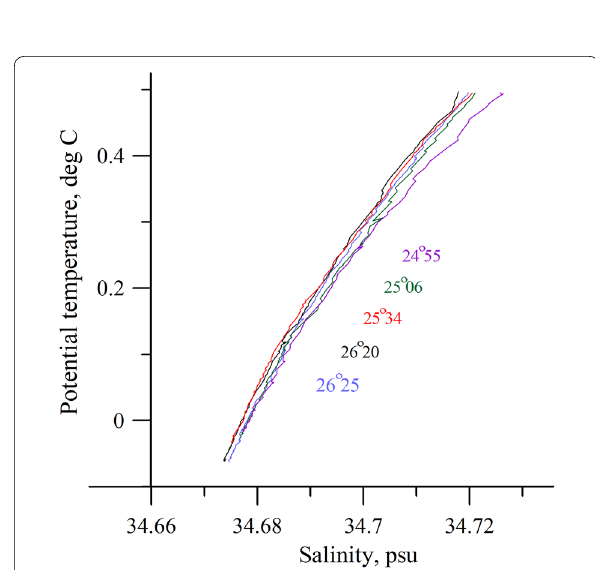
Fig. 10 Graphs of θ , S-relations along the pathway of the upper jet. Latitudes of the points are indicated on the graph with the same color as the